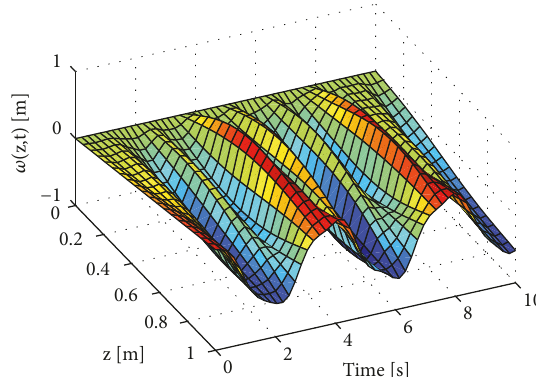
Figure 2: Deflection of the flexible link without control.